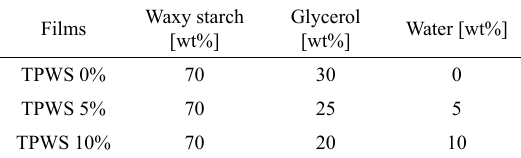
Table 1. Thermoplastic waxy starch films